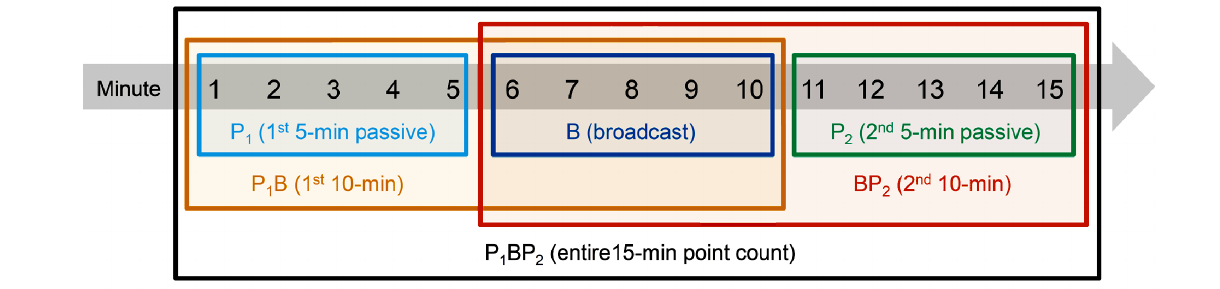
Fig. 2 . Schematic depiction (boxes) of various 5-min periods and combinations of consecutive 5-min periods within broadcast-assisted 15-min point counts used to assess the influence of call broadcast timing within point counts and survey duration on detection probability of marsh birds throughout the Great Lakes–St. Lawrence region, 2008–2016. P = first 5-min passive observation period consisting of min 1–5, B = 5-min broadcast 1 period consisting of min 6–10, P = second 5-min passive observation period consisting of min 11–15, P 2 first 10 min consisting of min 1–10, BP = second 10 min consisting of min 6-15, P 2 count consisting of min 1–15. Note that the Standardized North American Marsh Bird Monitoring Protocol recommends P 1